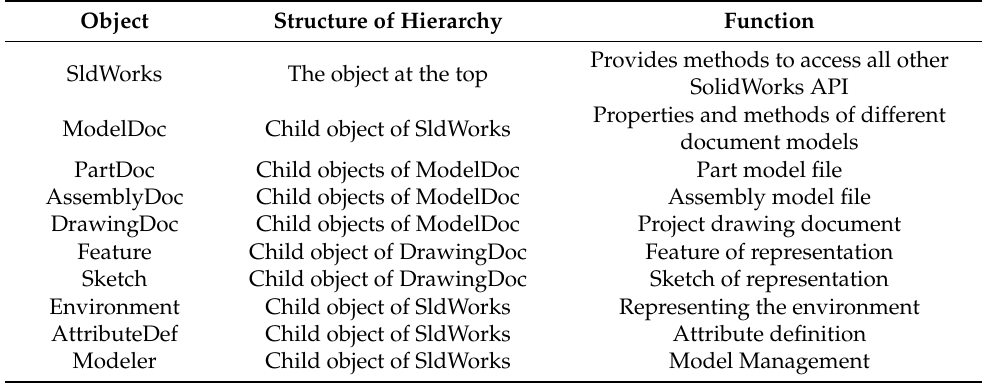
Table 2. Structure and functionality of the SolidWorks